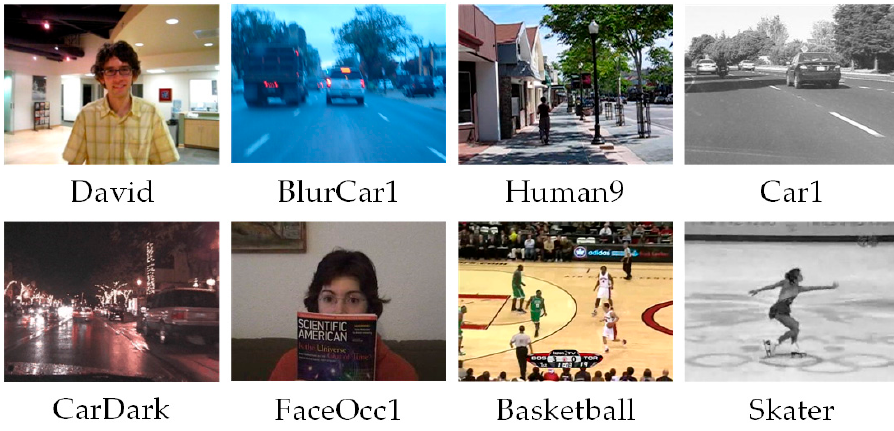
Figure 7. Representative images of some video sequences from the OTB2015 dataset.